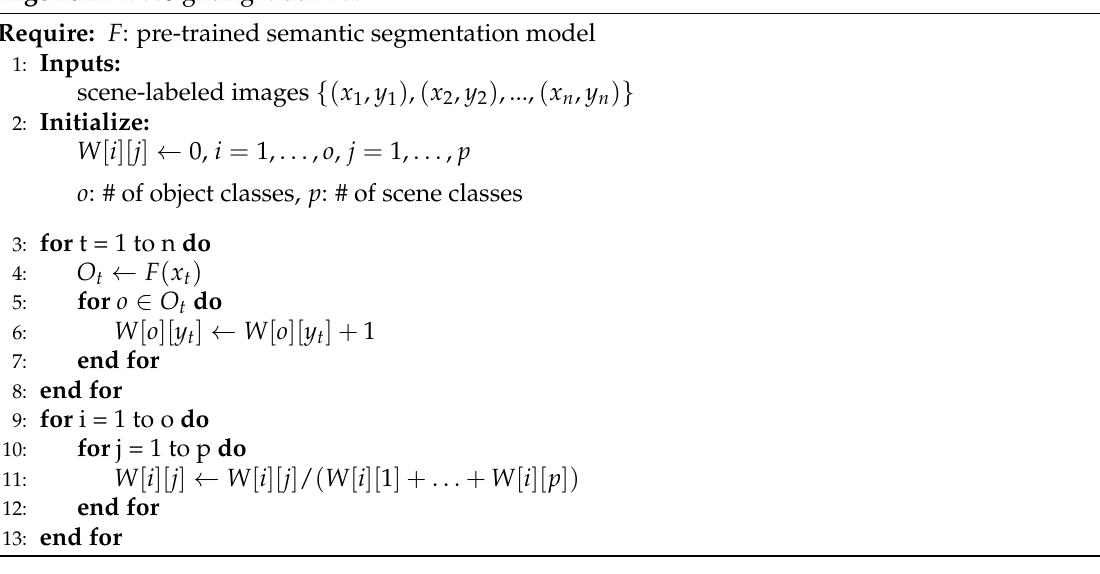
Figure 3. Construction of weight matrix W with a sample image. Algorithm 1 Weighting Matrix W